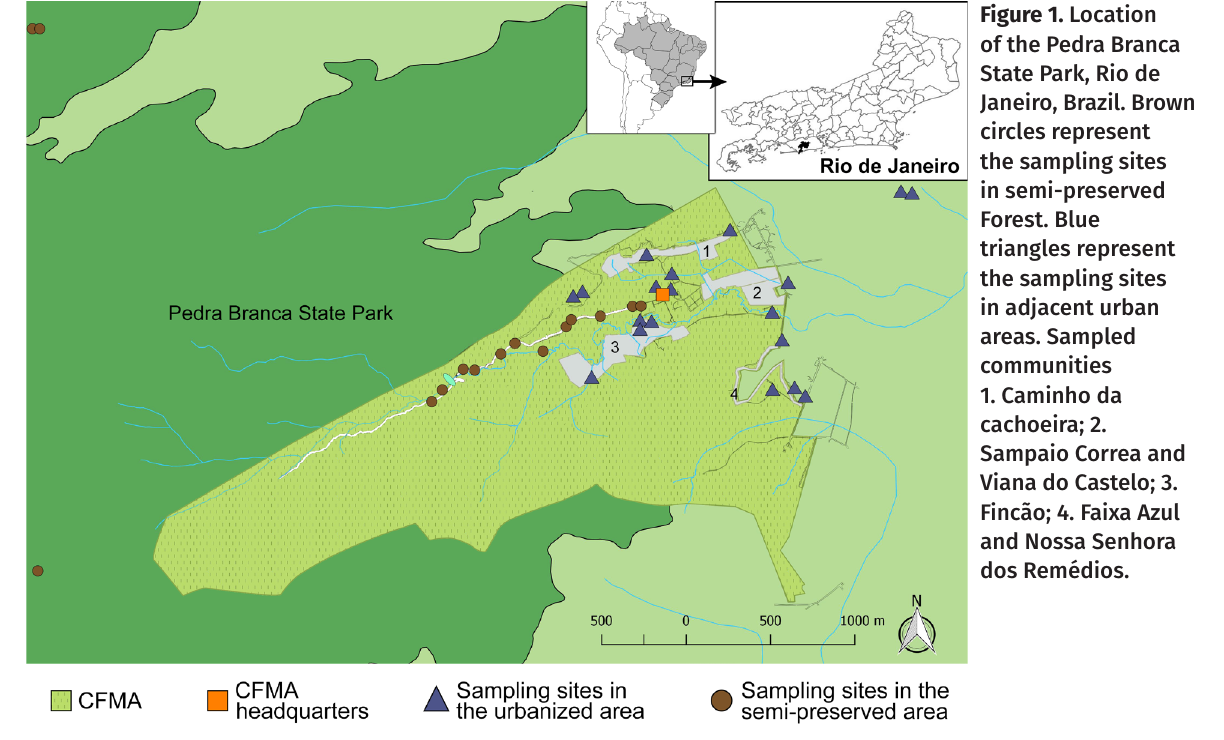
Figure 1. Location of the Pedra Branca State Park, Rio de Janeiro, Brazil. Brown circles represent the sampling sites in semi-preserved Forest. Blue triangles represent the sampling sites in adjacent urban areas. Sampled